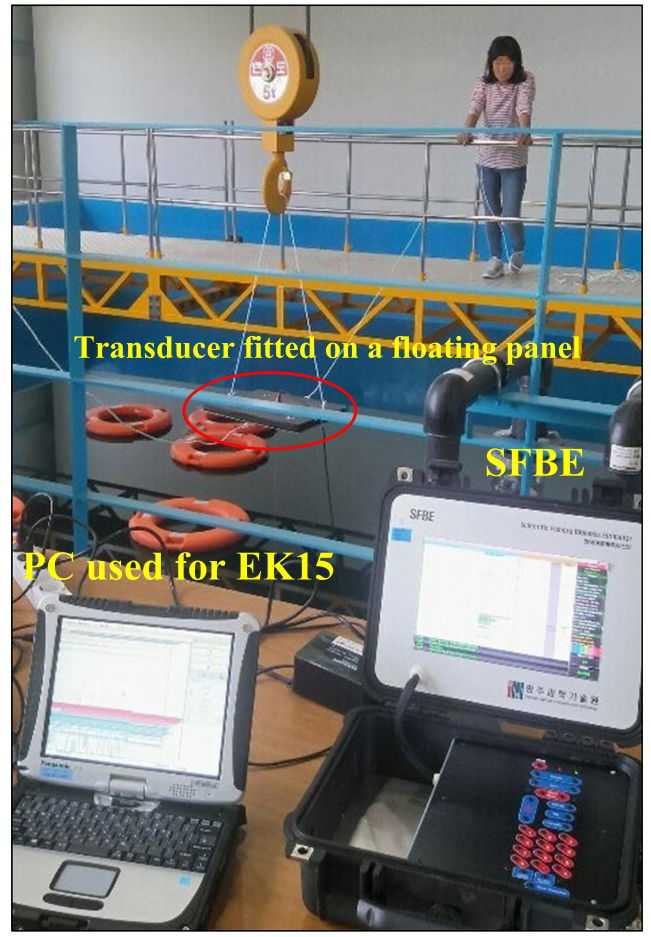
Figure 13. Experimental environment at KIOST. The left PC records EK15 and the right device is